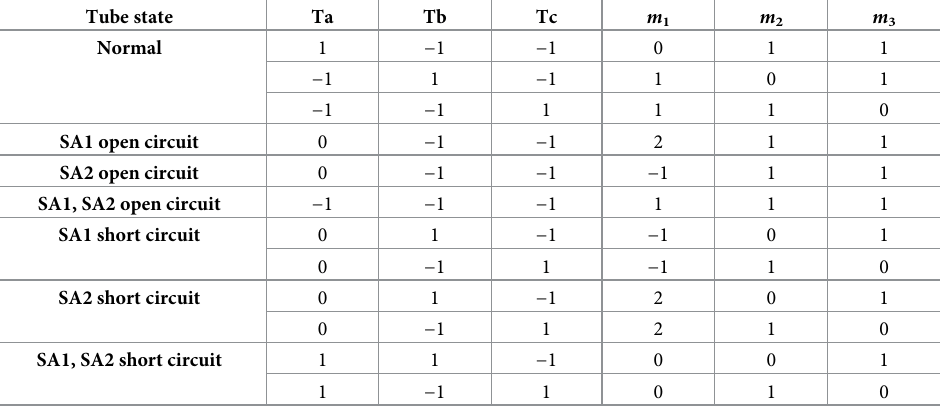
Table 2. Corresponding relationship between state of phase A switch tube and m 1 , m 2 and m 3 . Tube state Ta Tb Tc m 1